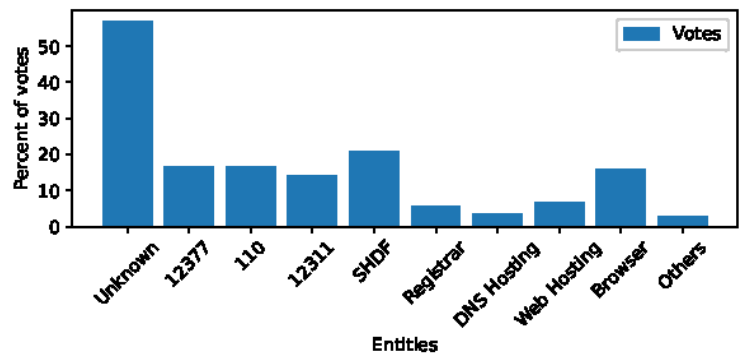
Figure 12. Percentage distribution of which entities people are aware of reporting